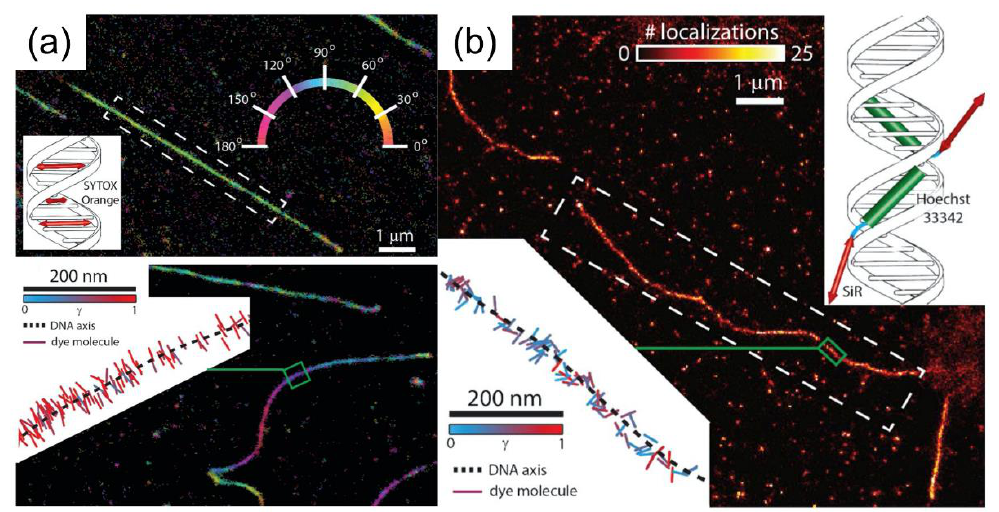
Figure 4. Super-resolved images and single-molecule orientation measurements acquired using DNA-staining dyes: ( a ) SYTOX Orange and ( b ) SiR-Hoechst. The images were reproduced with permission from Backer et al., published by the Optical Society of America, 2016 [28].